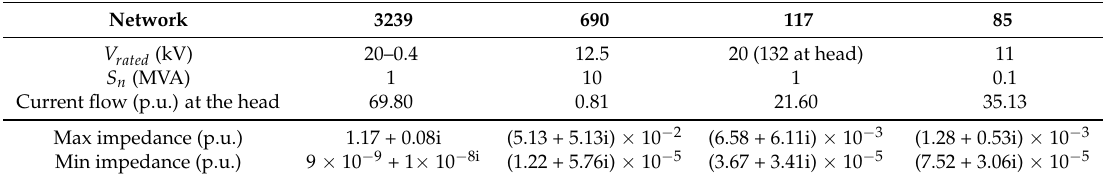
Table 1. Parameters of the tested networks.